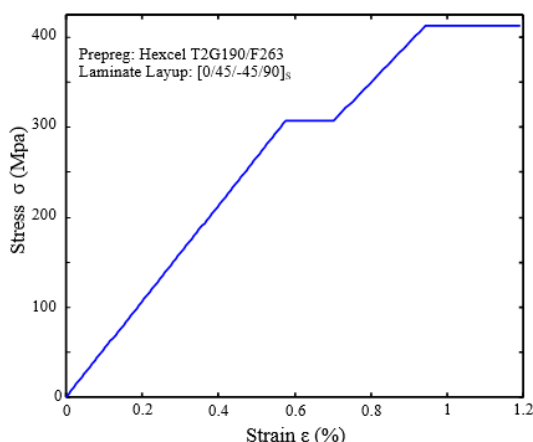
Figure 8. Predicted uniaxial tensile stress–strain diagram based on the classic laminate theory (CLT).